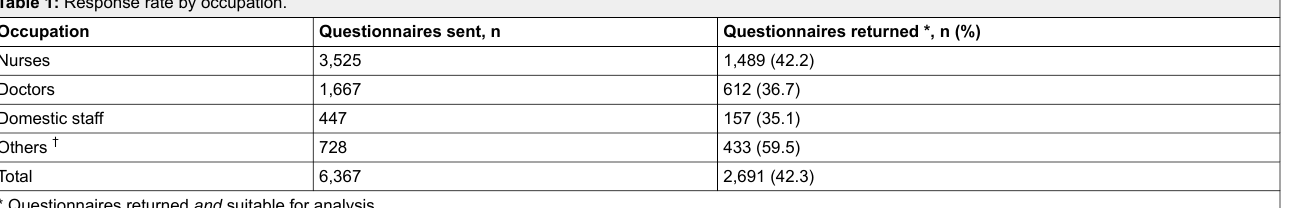
Table 1: Response rate by